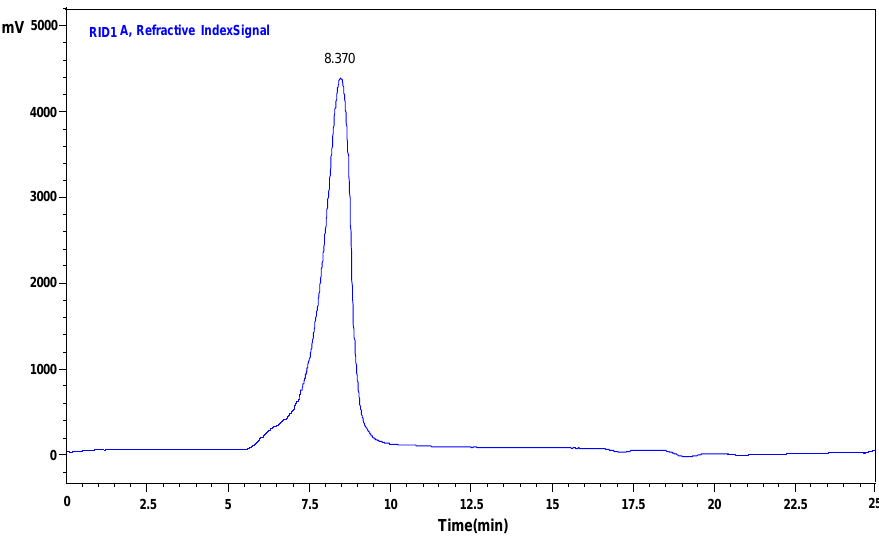
Figure 1. HPLC chromatograms of ZSP about molecular weight distribution.